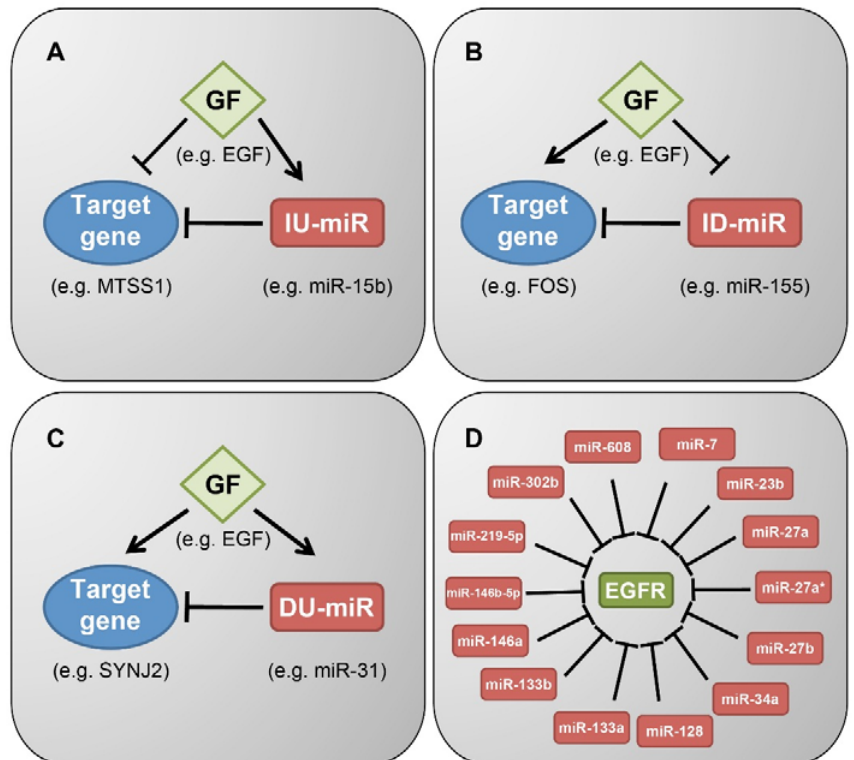
Figure 3. Network modules incorporating microRNAs and growth factor signaling pathways. ( A ) A feed-forward loop (FFL), whereby EGFR signaling down-regulates